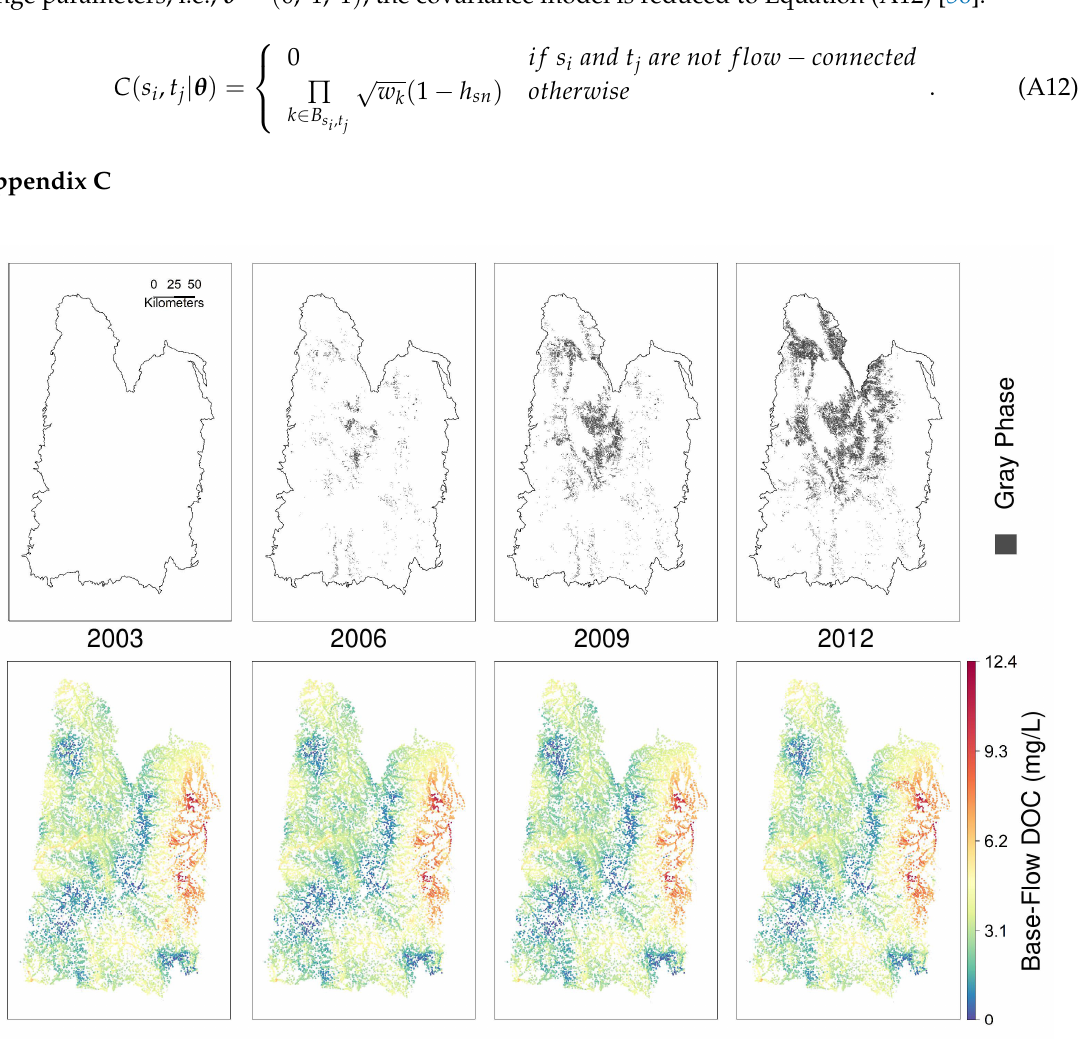
Figure A10. Comparison of gray-phase areas affected by the MPB and predicted base-flow DOC concentrations in the region of interest for the years 2003, 2006, 2009, and